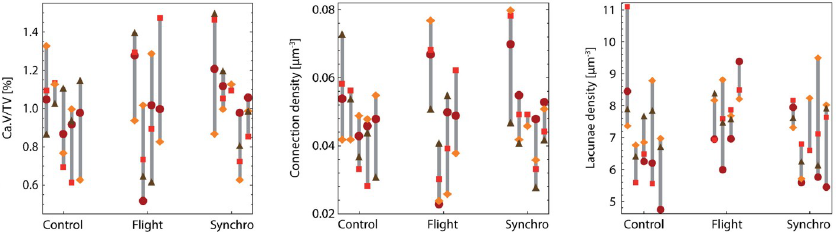
Fig 5. LCN parameters. Bone volume fraction of canalicular porosity (Ca.V/TV), density of connections and density of lacunae for Control, Flight and Synchro groups, for all four quadrants (light squares: lateral;dark squares: medial; diamonds: anterior/posterior). Intra-individual inter-individual variations within one group are large compared to measurement uncertainties and to the differences between groups.